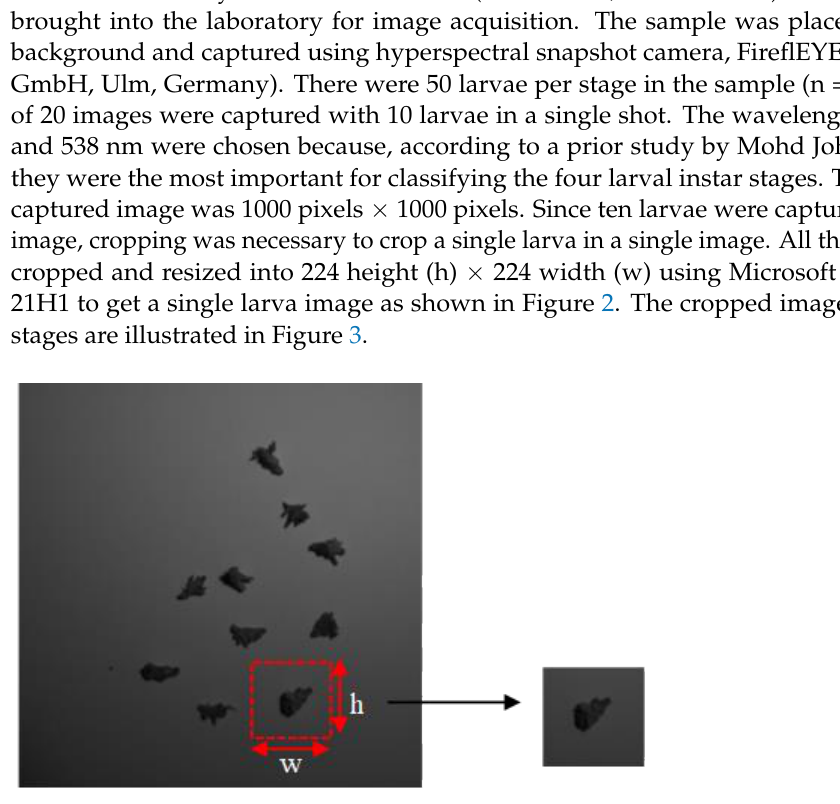
Figure 3. Images of cropped larvae, ( a ) S2, ( b ) S3, ( c ) S4, ( d ) S5. 2.3. Data Augmentation Data augmentation aims to increase the number of samples in order to minimize the risk of overfitting and boost the accuracy of classification [37]. Therefore, image augmen- tation process was done, and the techniques were chosen carefully to preserve the actual size of the bagworm according to their instar stage (S2 to S5). The augmentation methods included intensity transformations (i.e., brightness and contrast) as well as random geo- metrical transformations (i.e., rotation, translation, horizontal flipping, and vertical flip- ping). The brightness and contrast interval were 0.5. The rotation was done using clock- wise rotation along 0° (original images), 45°, 90°, 135°, 180°, 225°, 270°, and 315°. The trans- lation ratio of the image was 0 width and 0.1 height. Meanwhile, the probability of the flipping was 0.5. All these techniques were successfully performed and produced a total of 9000 images. Training and testing datasets were split from the total dataset, where 70% (6300 im- ages) of the total images were used for training and another 30% (2700 images) were used for testing. During training, 5-fold cross validation was applied to assess the accuracy of the classifiers. Each dataset is divided into five equal folds at random. The classifier is trained on the four remaining folds after one-fold is removed for validation in each repe- tition. The accuracy of the classifier is then evaluated on the fold that was removed. This process is repeated until all folds have been tested. The major benefit of this approach is that all models are evaluated across all samples in the dataset, with no overlap between the training and testing datasets. The number of training and testing images were bal- anced for each instar stage as shown in Table 2 to avoid imbalanced data issues, where the accurate result frequently favors a majority class.